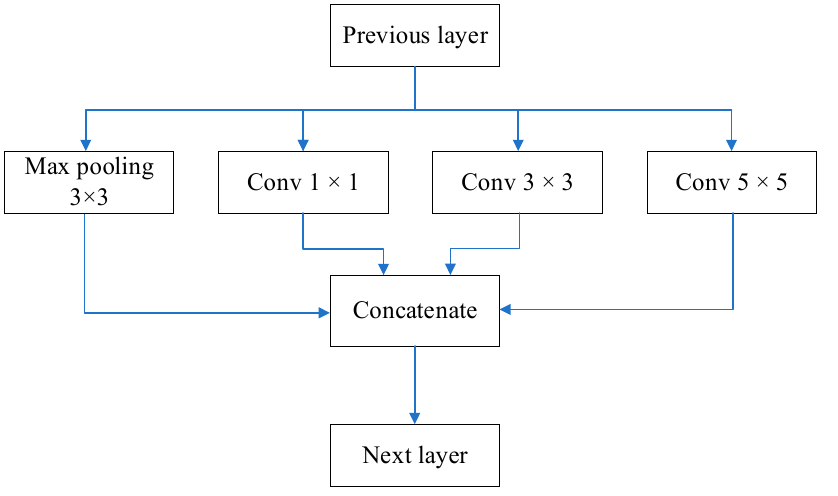
Figure 2. Basic Inception Architecture.